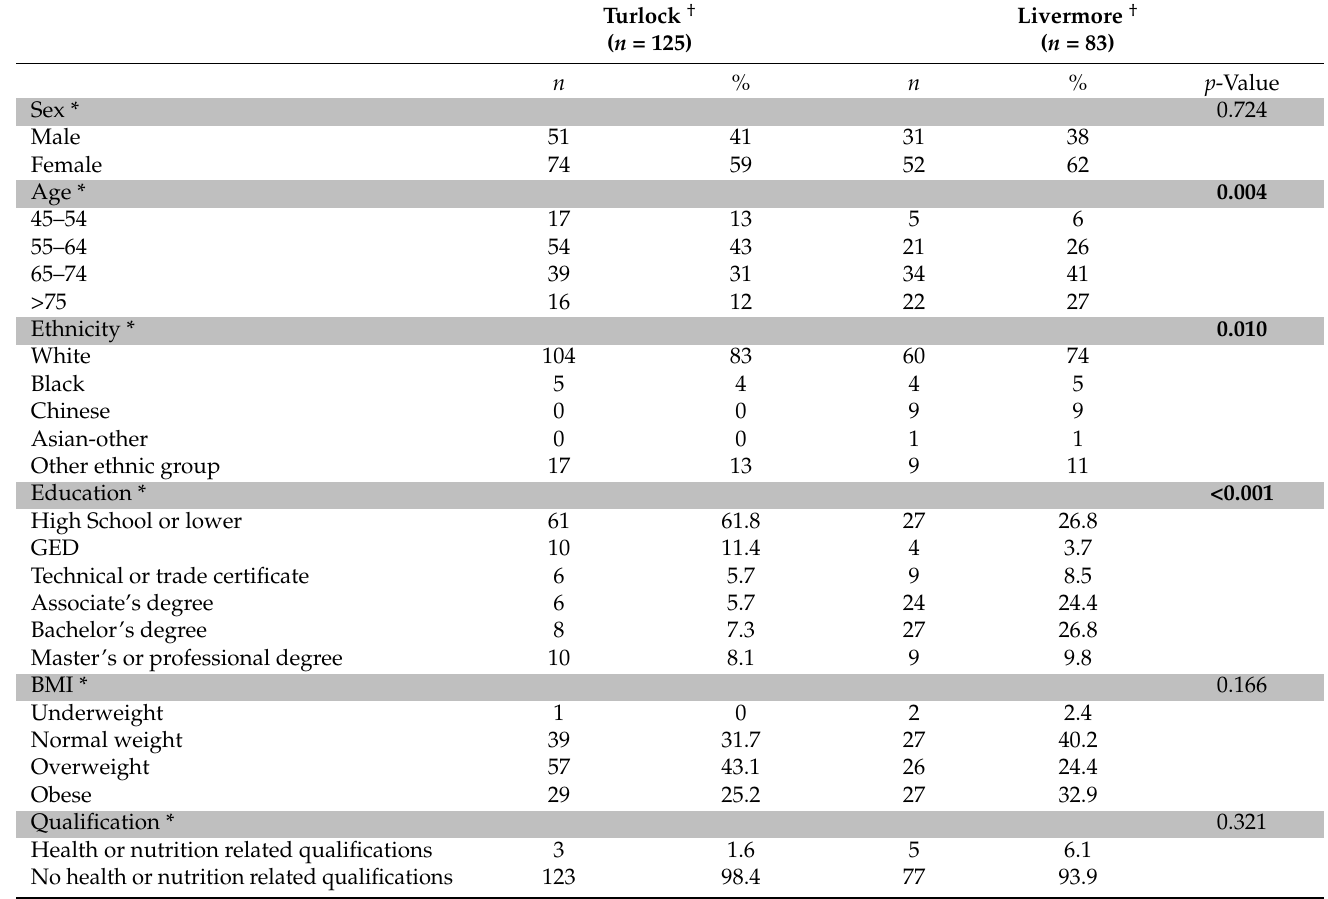
Table 1. Demographics of participants in Turlock and